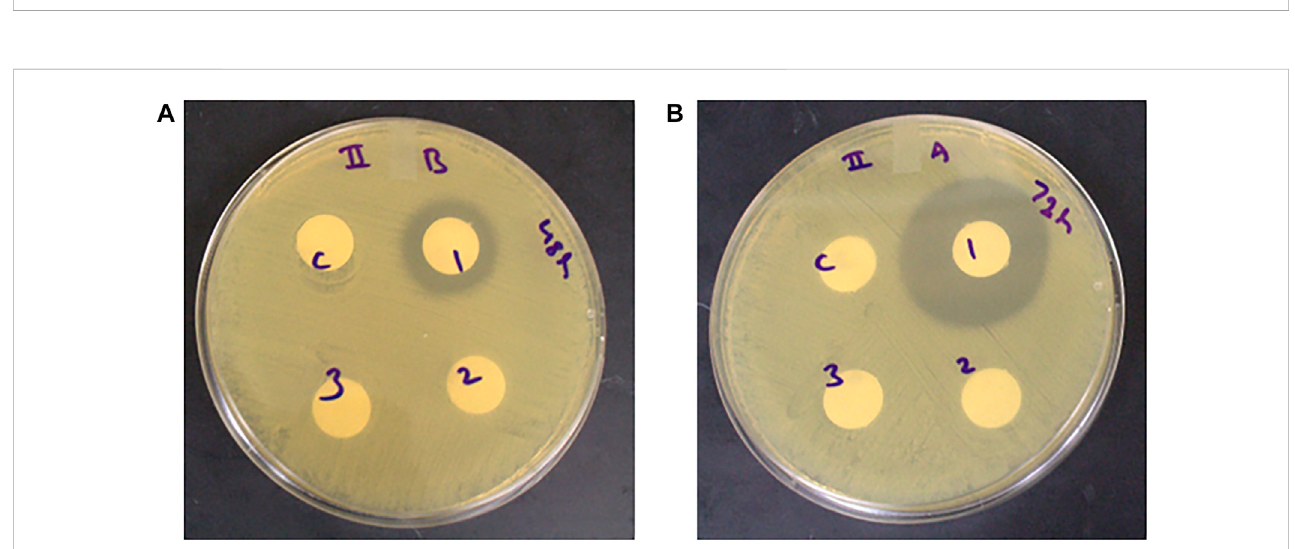
Antimicrobialactivityofunfermentedand L.heveticus fermented(withandwithoutpHadjustment)cornDDGSextractsagainst H.pylori at (A) 48-and (B) 72-h fermentation time points. C- control (sterile water), one- unfermented extract, two- fermented extract (adjusted pH), and three- fermented extract (unadjusted pH). Zone of inhibition measured in millimeters